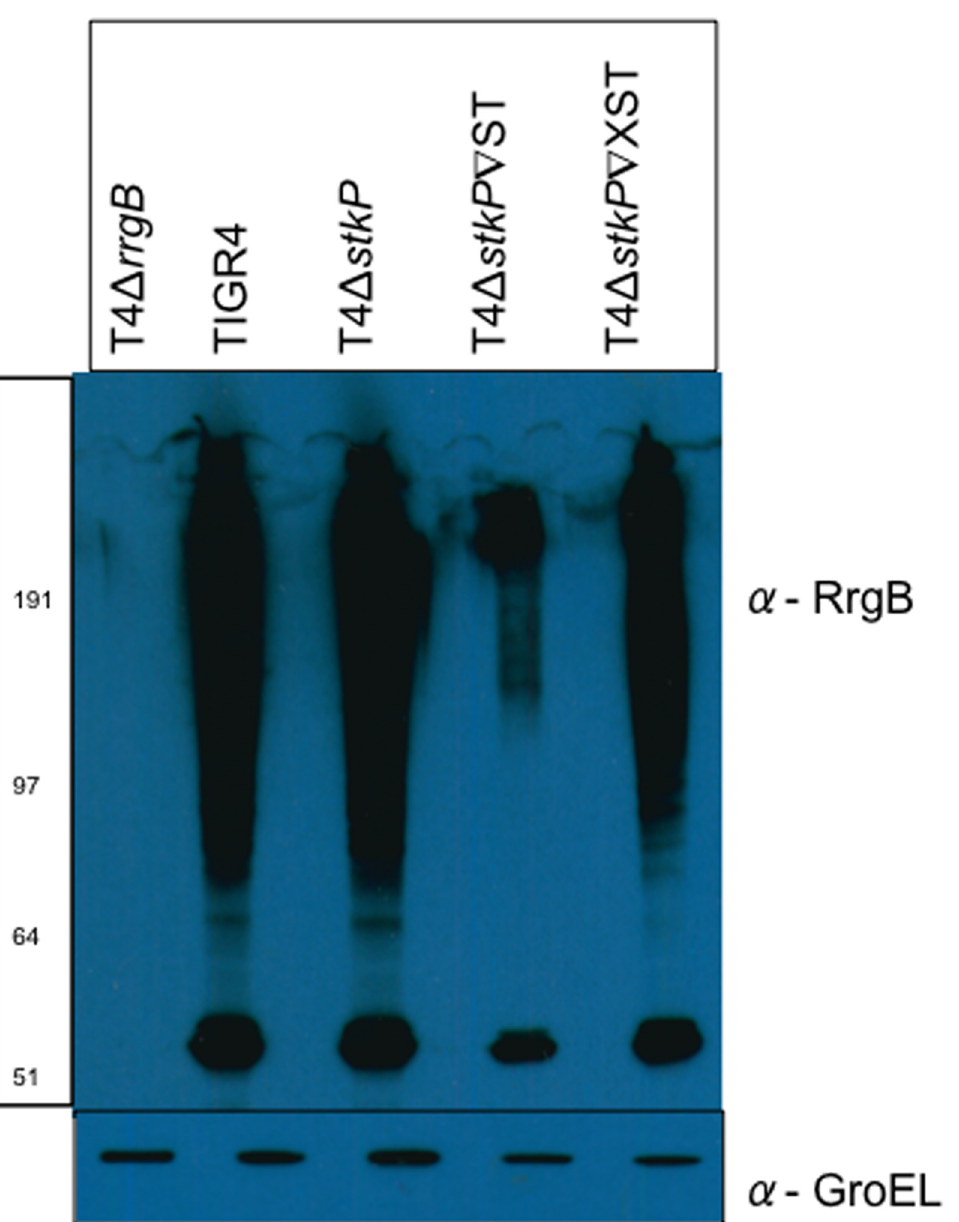
Fig 3. RrgB protein expression in T4 Δ stkP and StkP complemented strains. Western blotting analysis was performed on TIGR4, T4 Δ stkP , T4 Δ stkP r ST, T4 Δ stkP r XST and T4 Δ rrgB at OD 0.6 (OD 600nm ) looking at expression of RrgB in all strains ( α -RrgB antibody). Equal protein loading was confirmed by equal expression of GroEL ( α -GroEL